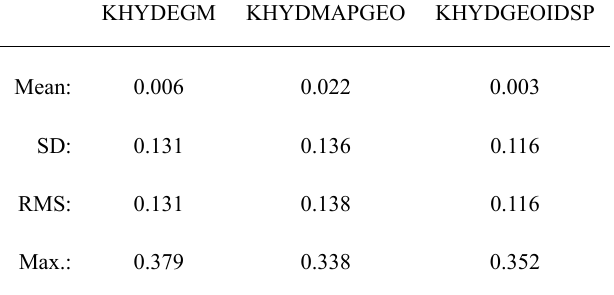
(linear variogram) regarding validation